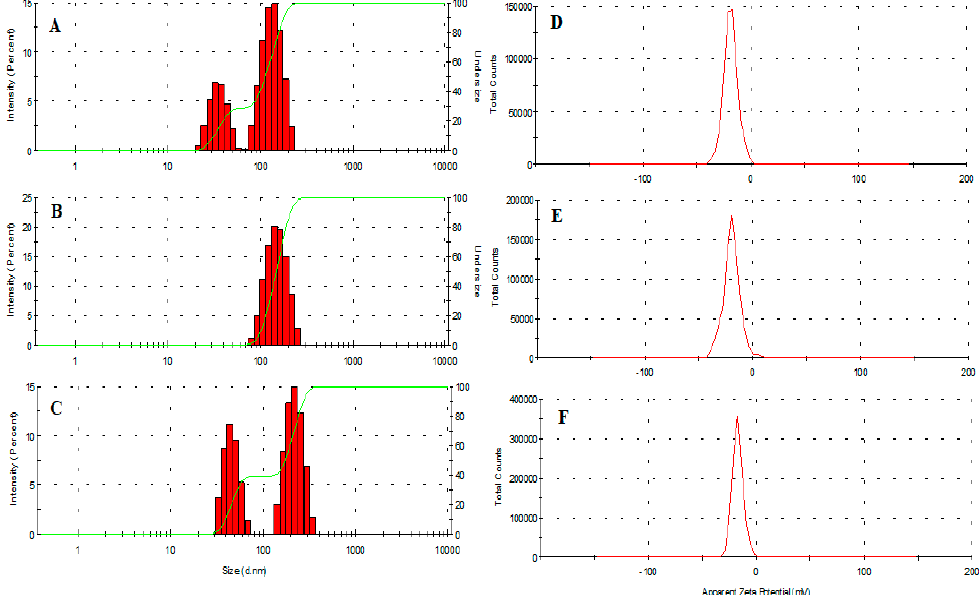
Figure 2. ( A ) Average hydrodynamic diameter of synthesized MIH-MP. ( B )